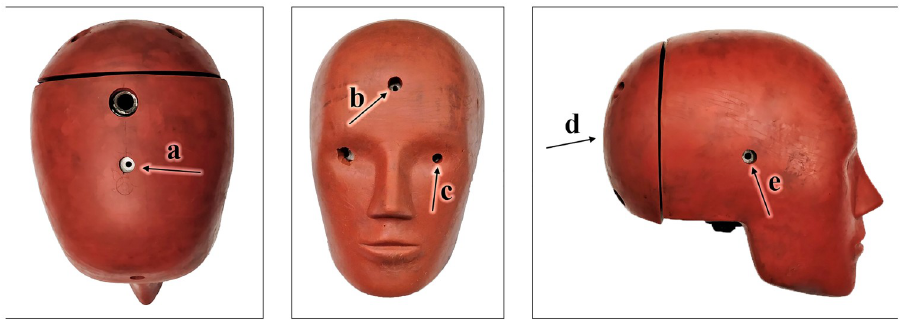
Fig 4. Views of Hybrid III head with pressure sensor locations indicated. (a) crown, (b) forehead, (c) eye, (d) back head, and (e) ear.